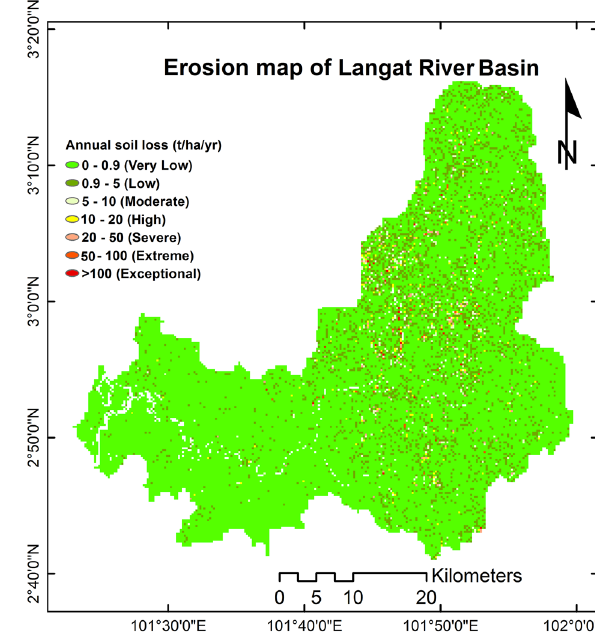
Fig. 9 Predicted soil erosion map of the study